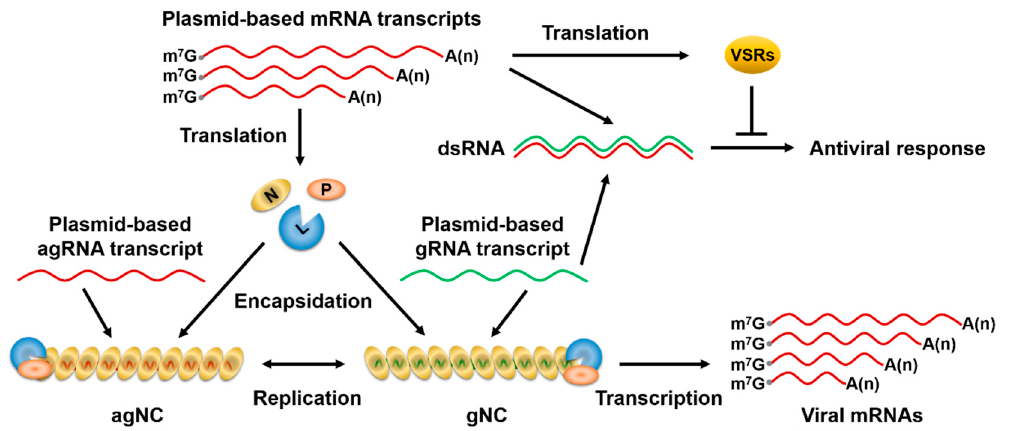
Figure 1. Positive- and negative-strand approaches for recovery of recombinant rhabdoviruses from cloned cDNAs. The positive-strand approach relies on plasmids-based co-expression of viral antigenomic (ag)RNA with the N, P, and L nucleocapsid (NC) core proteins to assemble the antigenomic (ag)NC, which serves as a replication template to produce genomic (g)RNA that is wrapped along its length by the NC proteins to form genomic (g)NC. In the negative-strand approach, although base-pairing between plasmids-derived viral mRNAs and gRNA transcripts results in double-stranded (ds)RNA formation, antiviral RNAi responses are minimized in the presence of co-expressed viral suppressors of RNA silencing (VSRs). Therefore, gNC can be directly reconstituted from viral gRNA and NC proteins to jump-start viral transcription, and subsequent infection steps occur as in natural virus infections. m 7 G, N 7 -methylguanosine cap; A(n), polyadenylated